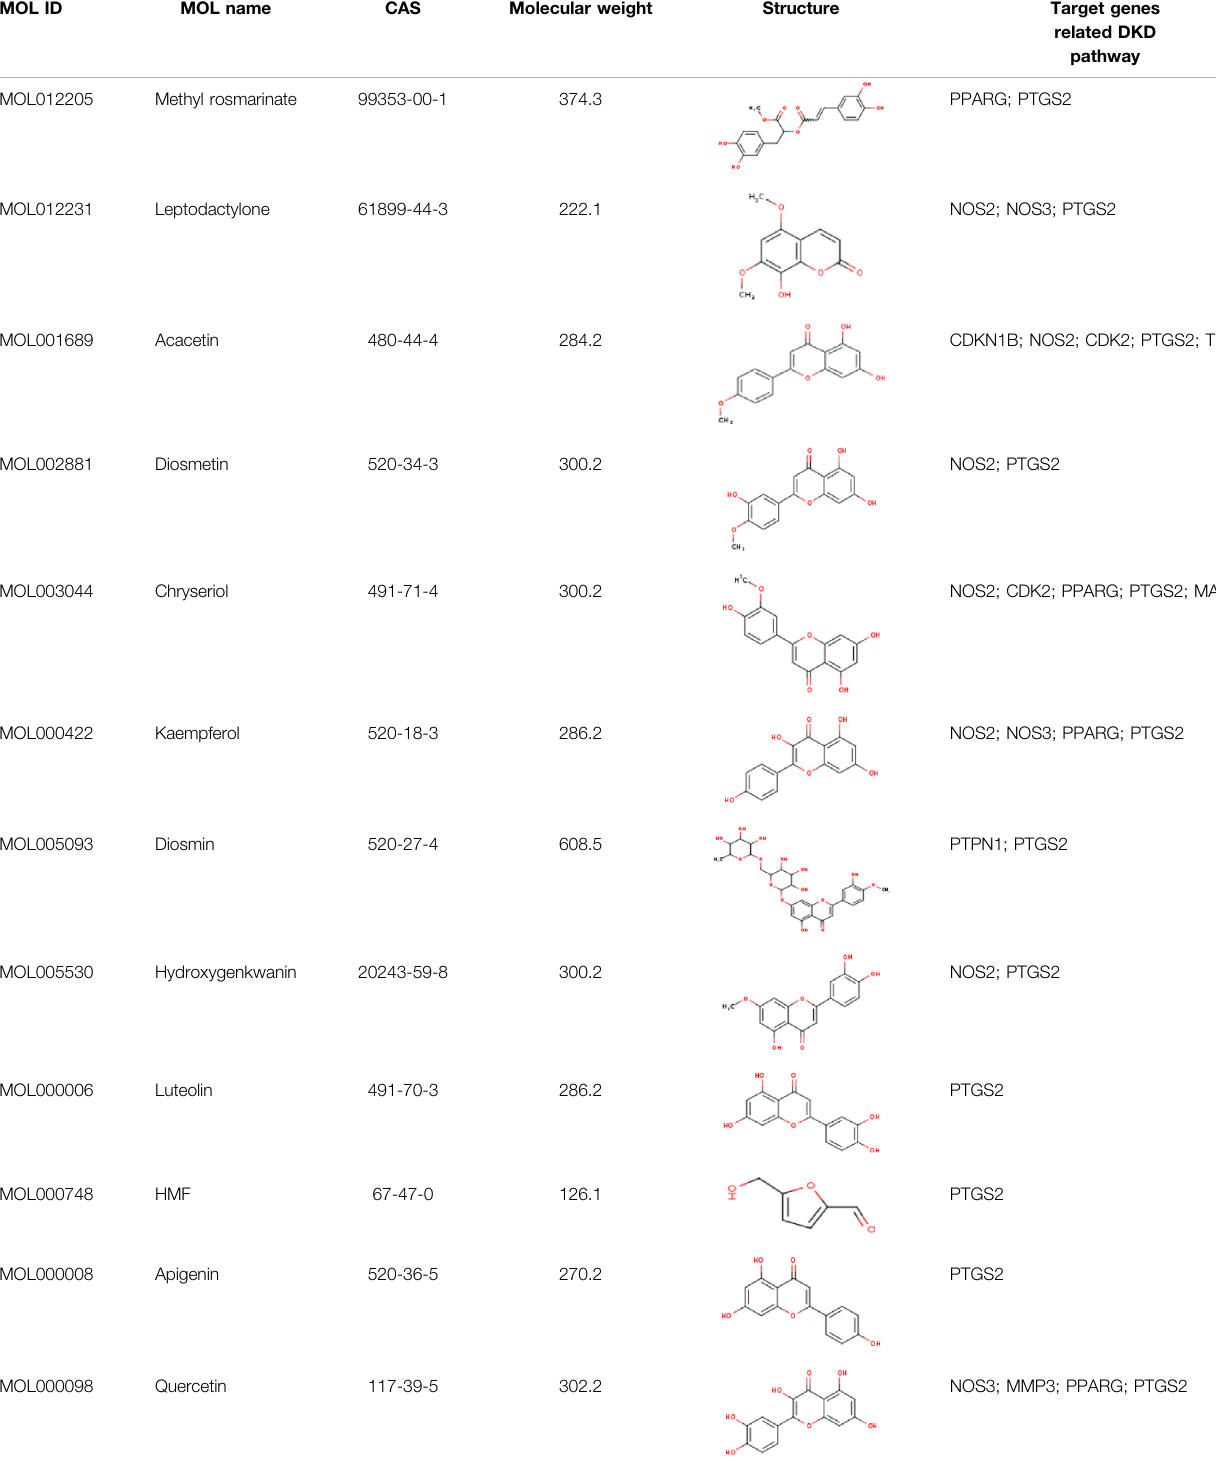
TABLE 1 | Active ingredients of LCH with DPP4 as the target gene, including their MOL ID, MOL name, CAS number, molecular structure and target genes involved in the DKD signalling